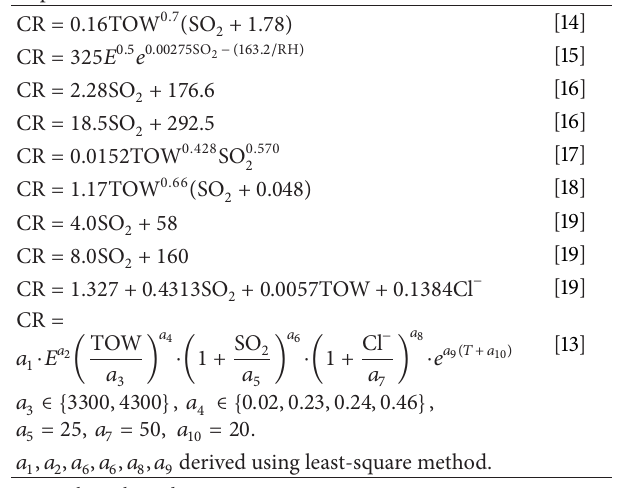
Figure 16: GP steel expression after dropping outliers. Table 8: Corrosion models in the literature. Expression Citation